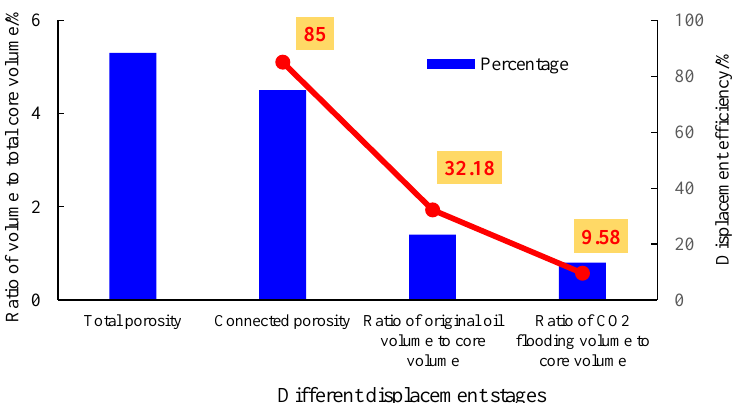
Figure 8. The Y29 – 100 core displacement efficiency and ratio of volume to core total volume in different stages.